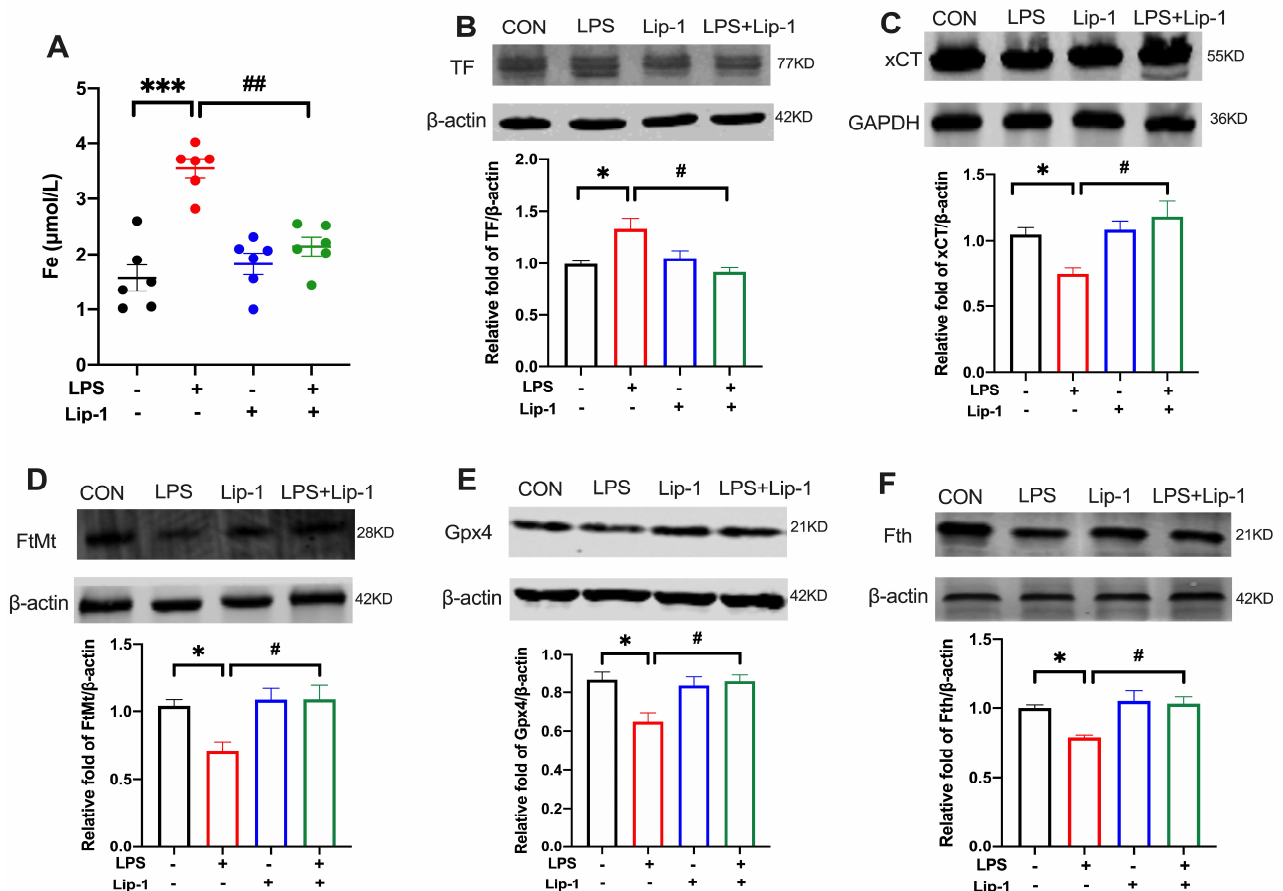
Figure 6. Liproxstatin-1 attenuated the iron deposition and altered expression of proteins related to ferroptosis in the hippocampus of mouse model of LPS microinjection. ( A ) The level of iron content in hippocampus ( n = 6). ( B – F ) Cropped gels and blots showing the protein expression and the graph of the protein expression of the ( B ) TF, ( C ) xCT, ( D ) FtMt, ( E ) Gpx4 and ( F ) Fth ( n = 6). Data are expressed as mean ± SE. * p < 0.05, *** p < 0.001 vs. CON group; # p < 0.05, ## p < 0.01 vs. LPS group. 3.5. Liproxstatin-1 Alleviated LPS-Induced Neuronal Damage in the Hippocampus TUNEL staining demonstrated neuronal death in the hippocampal DG region. Com- pared with the CON group, the TUNEL-positive cells number was significantly higher in the LPS group ( p < 0.001; Figure 7B). However, the number of TUNEL-positive cells was significantly lower in the LPS + Lip-1 group ( p < 0.001; Figure 7B). Nissl staining results revealed the morphological changes in neurons in the hippocampus DG region. As shown in Figure 7C, the Nissl-positive neurons were morphologically intact, while injured neurons had shrunken cell bodies. The proportion of Nissl-positive cells was decreased in the LPS group compared with that in the CON group ( p < 0.001; Figure 7D), while it was higher in the LPS + Lip-1 group than in the LPS group ( p < 0.001; Figure